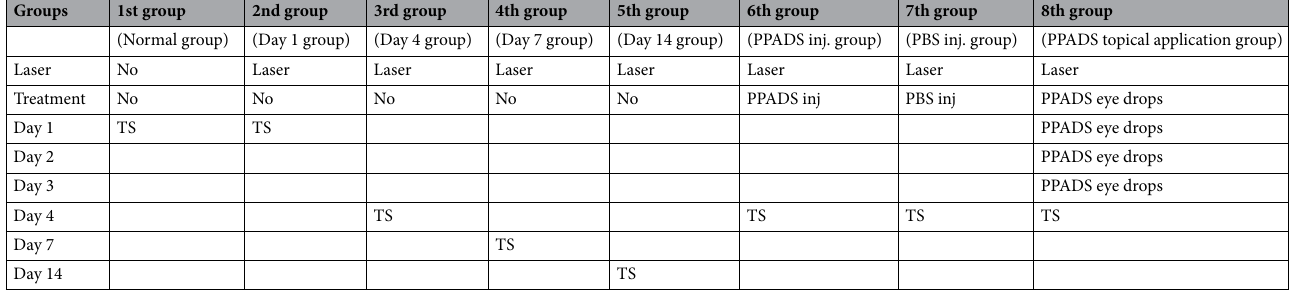
Table 1. The specific treatment approach of each group. TS take